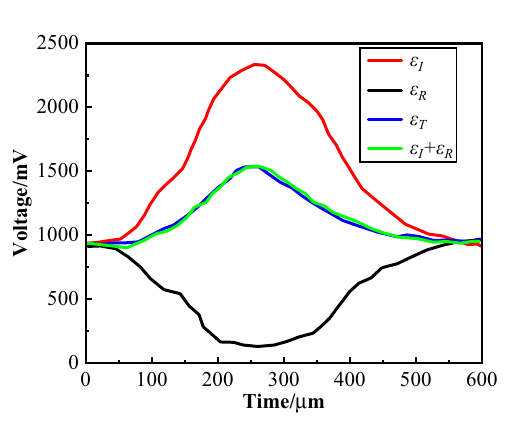
Figure 7. Typical